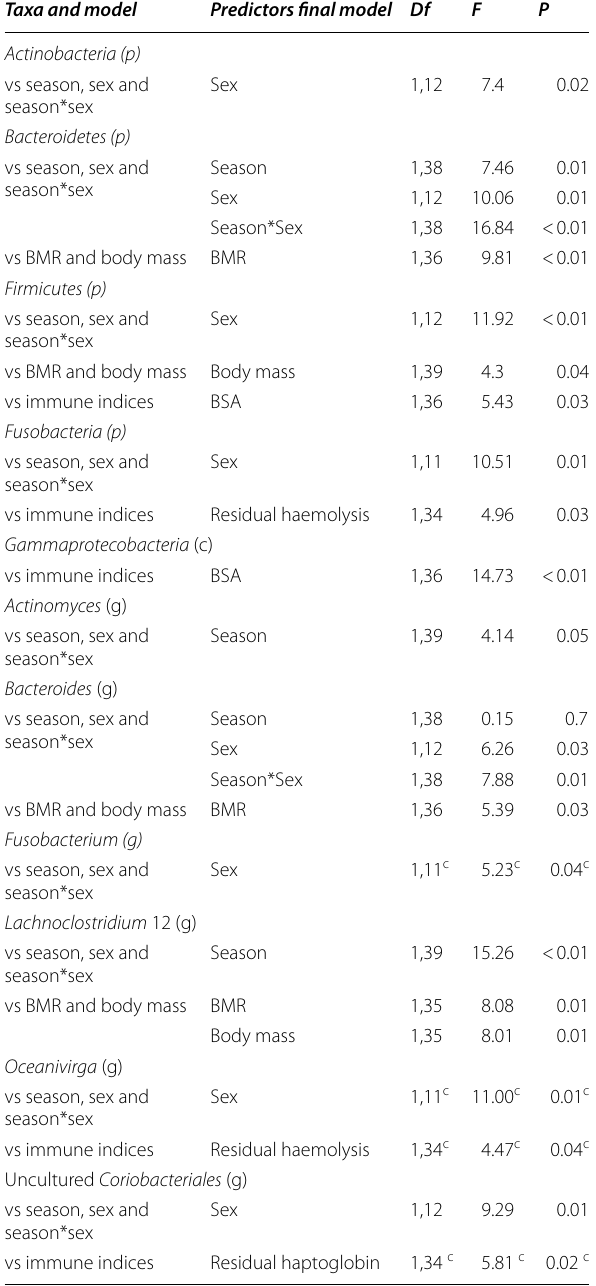
Table 4 LMM analysis of the logit proportions of the most abundant phyla a and genera